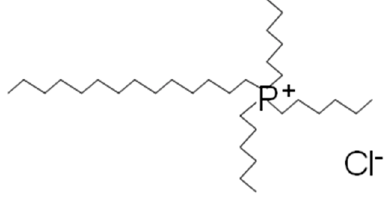
Figure 2. Structure of [P 6,6,6,14 ]Cl.